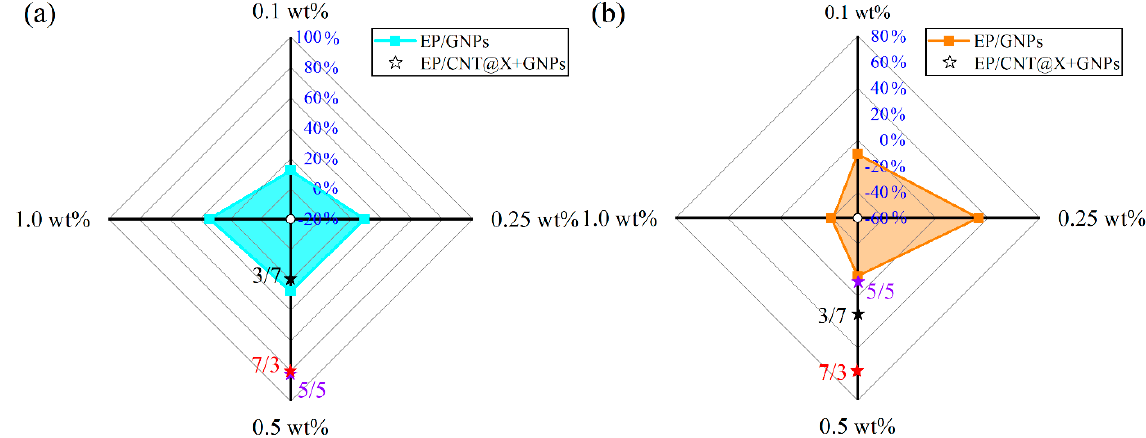
Figure 11. Radar plot for improved ( a ) dynamic compressive strength and ( b ) failure strain with respect to neat epoxy for different nanocomposite systems under a strain rate of 500/s.